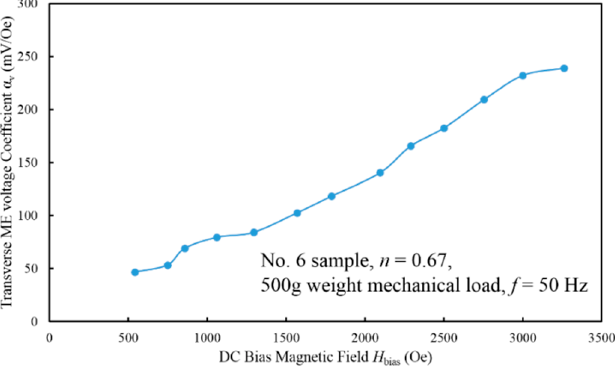
Figure 9. The induced transverse ME voltage coefficient as a function of the DC bias magnetic field for sample No. 6 at f = 50 Hz.